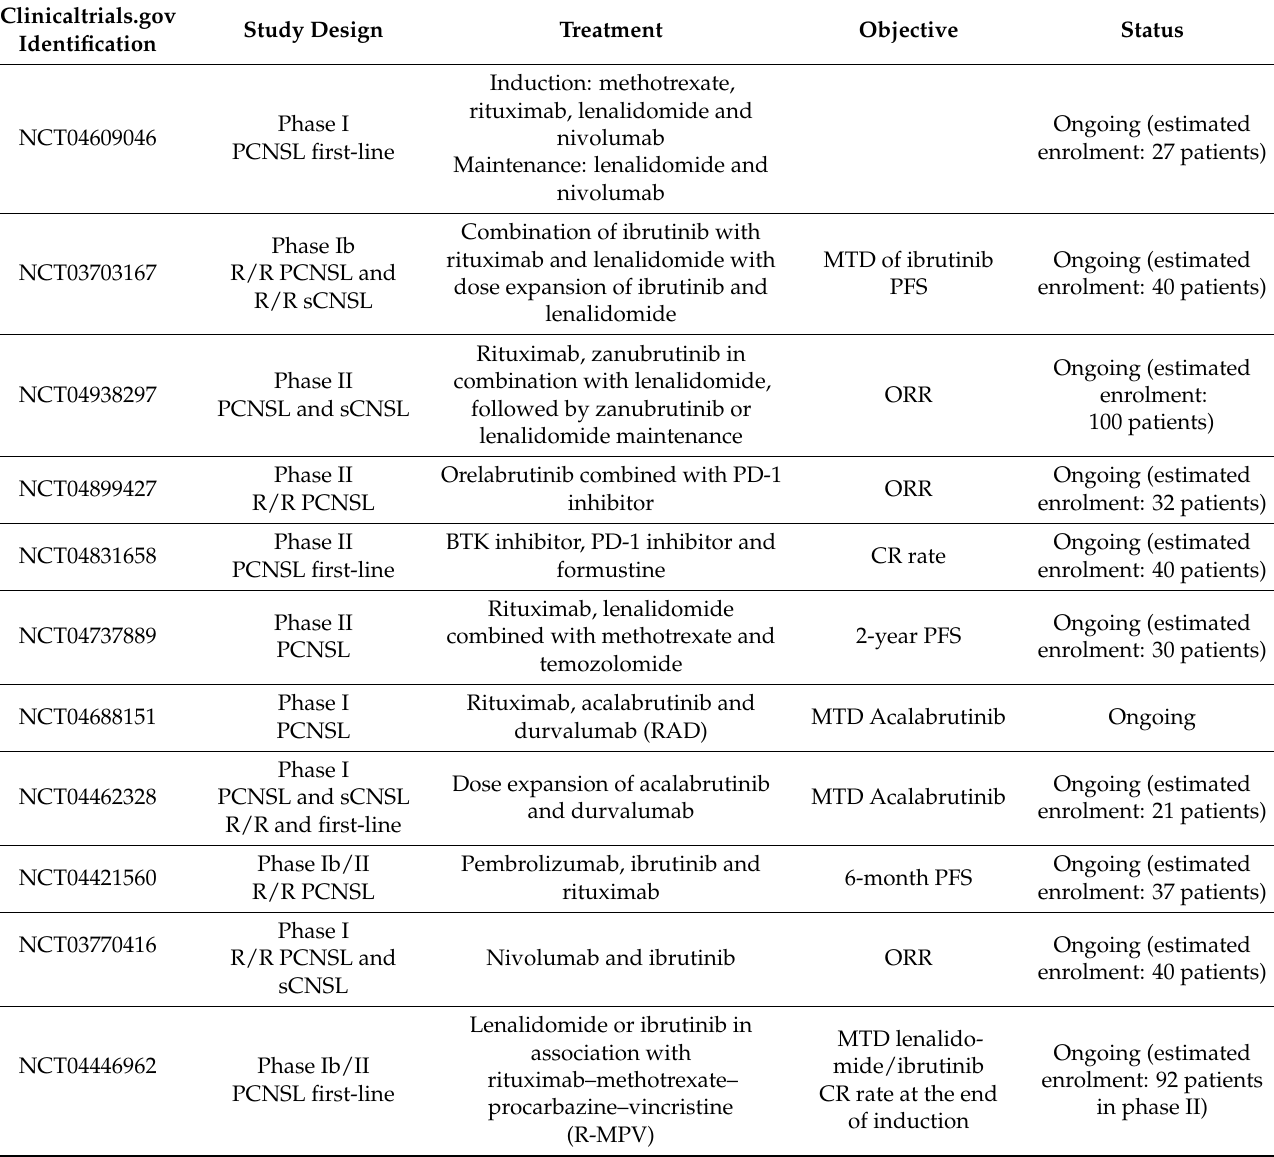
Table 3. Ongoing clinical trials of combined therapies targeting immune pathways. PCNSL: primary central nervous system lymphoma; sCNSL: secondary central nervous system lymphoma; R/R: relapsed or refractory; MTD: maximal tolerated dose; ORR: overall response rate; CR: complete response; PFS: progression-free survival.